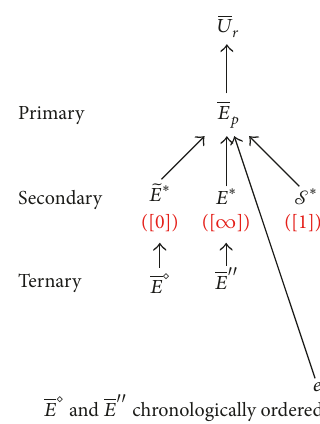
Figure 5: The causal structure of E ch with the event 𝑒 .